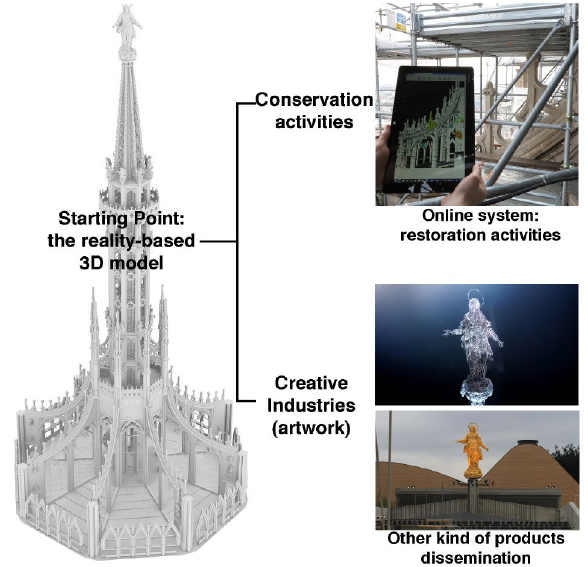
Figure 3 . From the model made for conservation purposes, it is possible to extract other kind of products, useful for the dissemination and fruition to non-expert public.